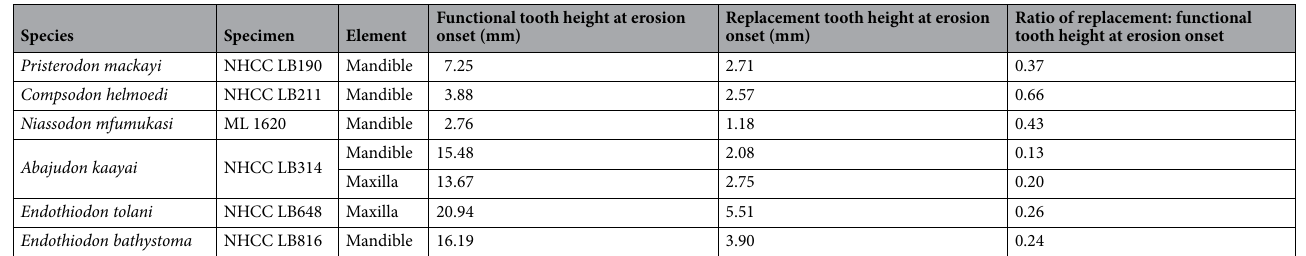
Table 2. Heights of functional and replacement teeth at the onset of erosion during the replacement process. Note that these measurements could only be taken on specimens that captured this stage of replacement.